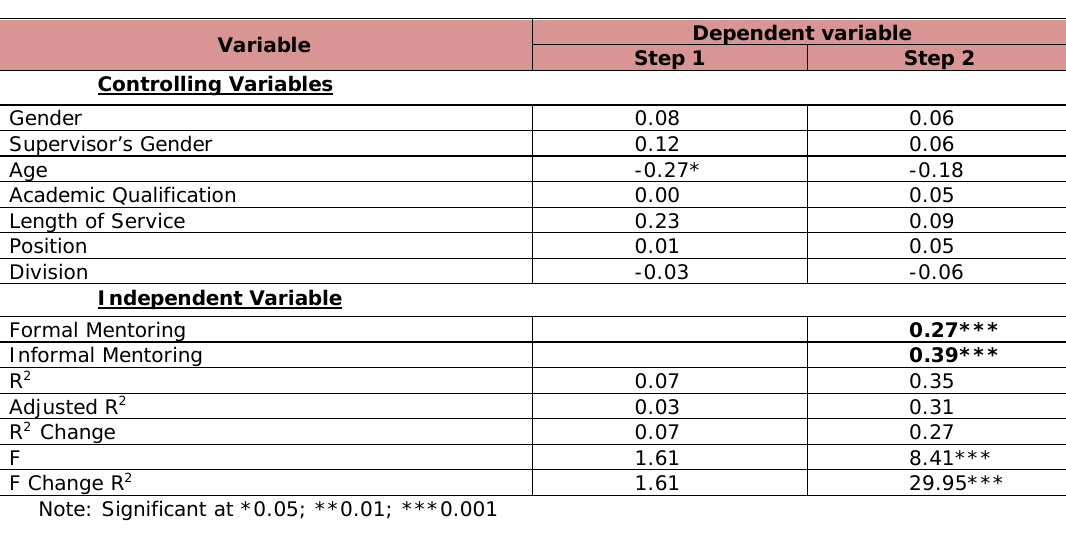
Table 6. “Result for stepwise regression analysis for career development as dependent variable”. Source: